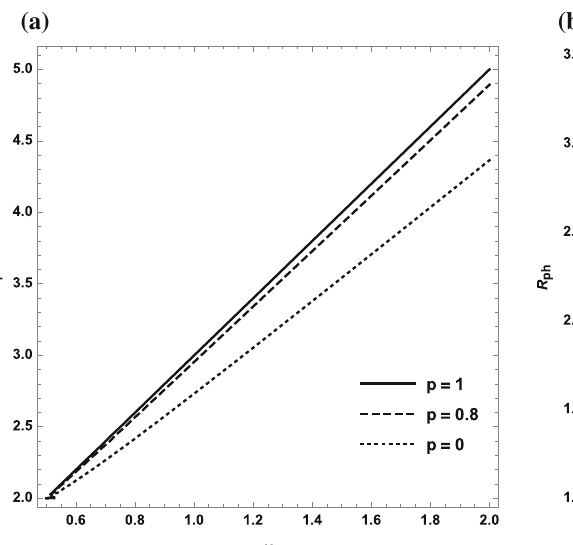
ent values of γ . For comparison we include the photon sphere for the Kerr. The parameter a corresponds to the rotation parameter of the Kerr metric. R ph is given in units of